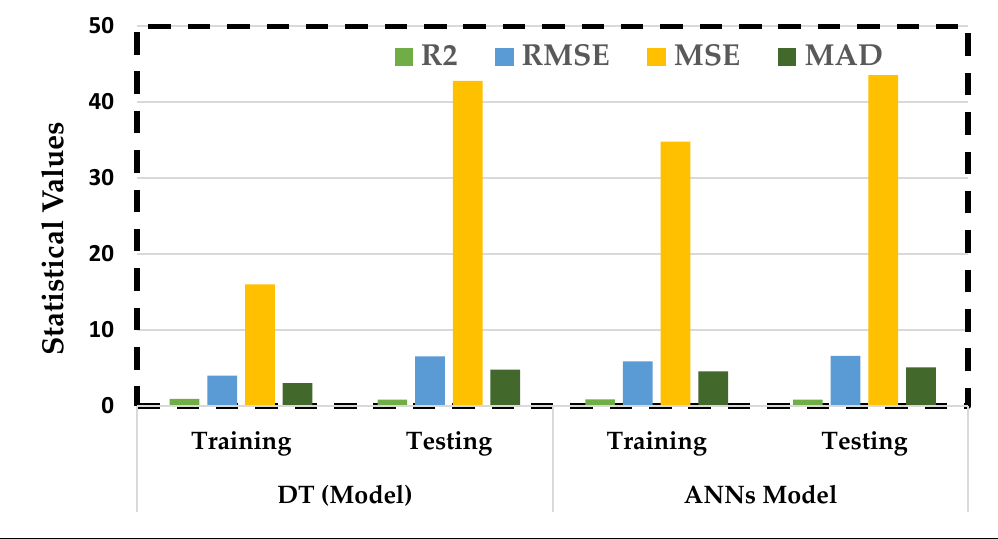
Figure 11. Relative Variable Importance for Different Factors.